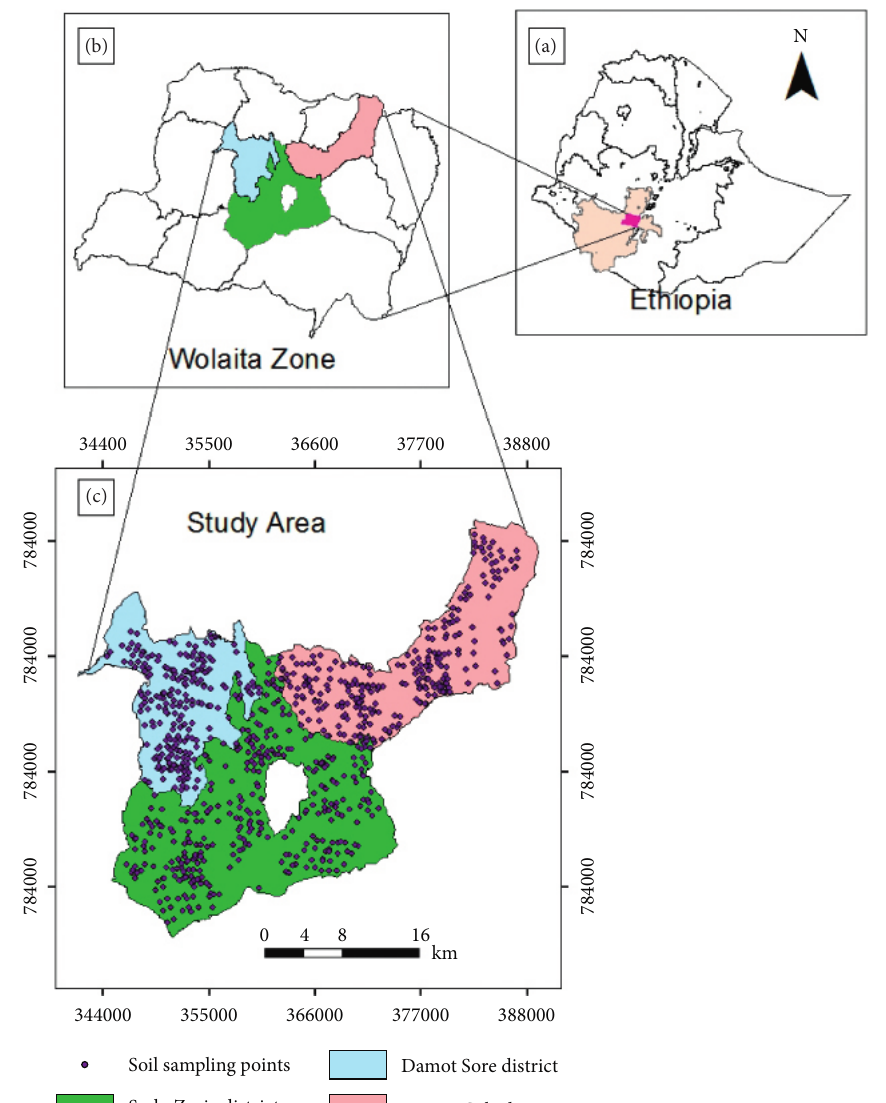
Figure 1: The location map of Wolaita zone in Ethiopia (a), study districts in Wolaita zone (b), and soil sampling points in the study areas